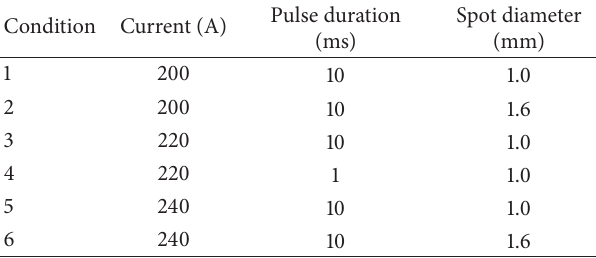
Figure 1: Schematic illustration of dumbbell-shaped tensile speci- men (ISO6871). Table 1: Laser emission parameters used in this